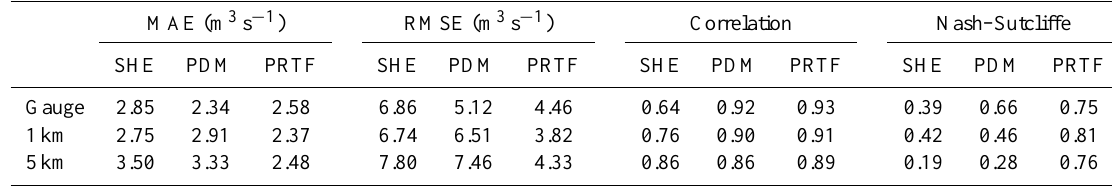
Table 4. Statistics of performance for different model output for convective events.